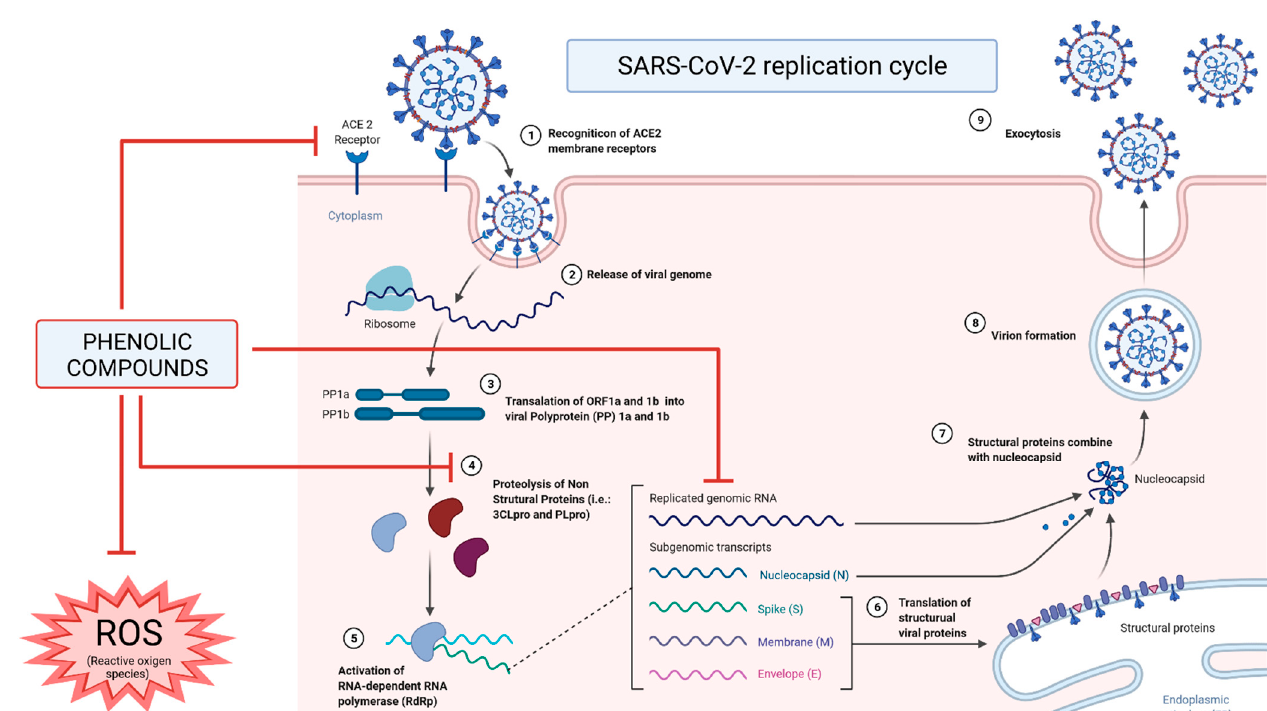
Figure 2. Mechanisms of action and inhibition of phenolic compounds against severe acute respiratory syndrome of coronavirus 2 (SARS-CoV-2) on its replication cycle and in the host’s immune response.